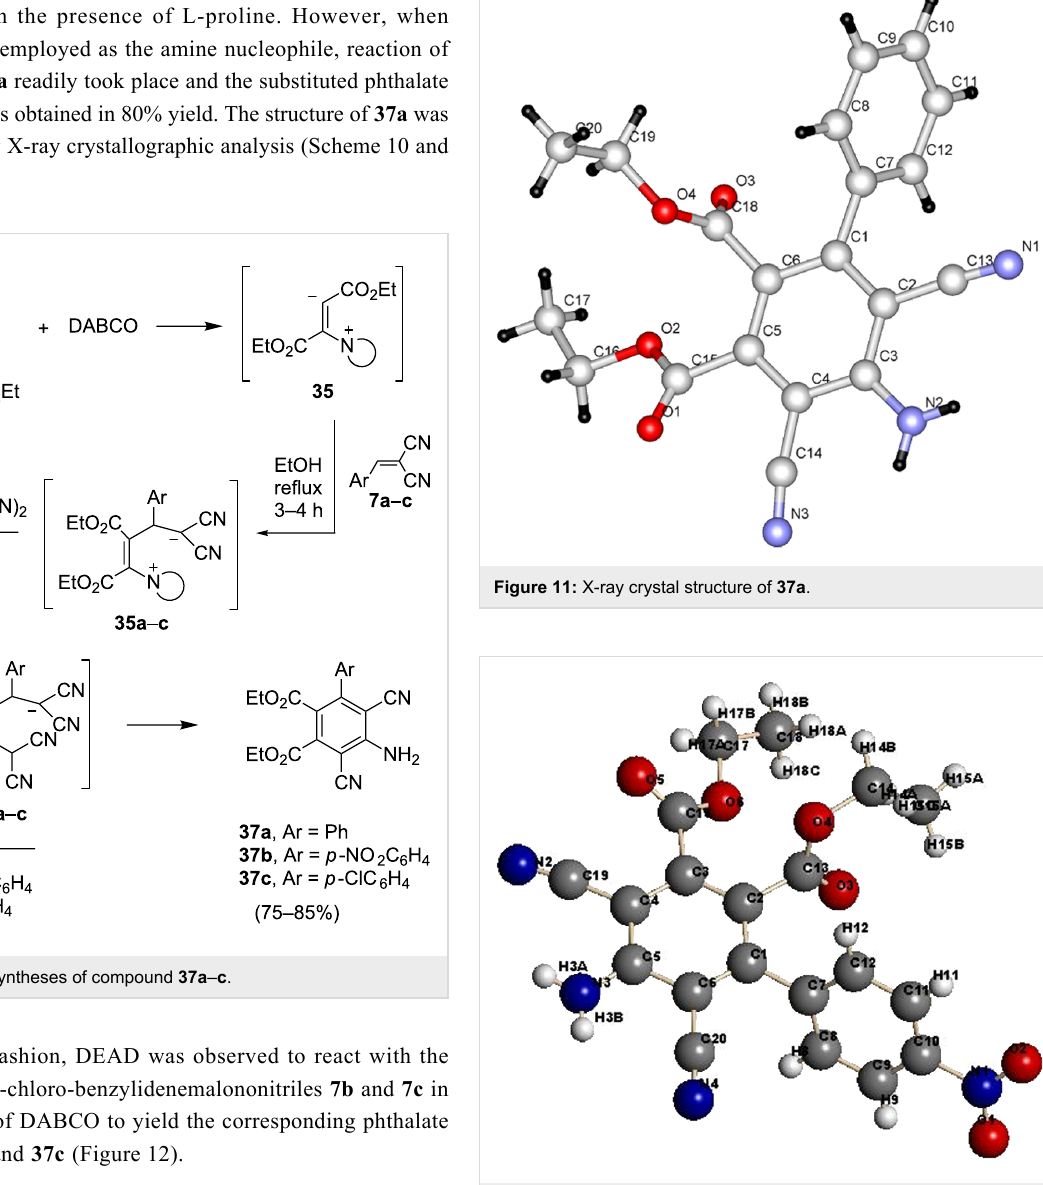
Figure 12: X-ray crystal structure of 37b